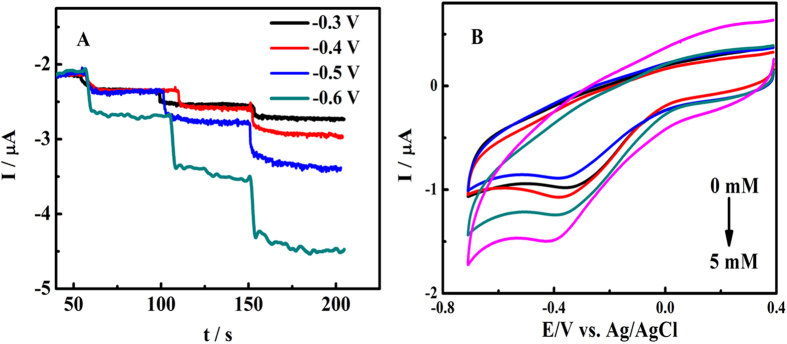
Cyclic voltammograms of (A) Co3O4/N-rGO, N-rGO and Co3O4/rGO modified GC electrodes in 0.1 M PB solution (pH 7.0) containing 5 mM H2O2 and (B) Co3O4/N-rGO modified GC electrode in 0.1 M PB solution (pH 7.0) containing different concentration of H2O2 (from the top: 0, 0.5, 1, 2 and 5 mM). Scan rate 50 mV s−1.